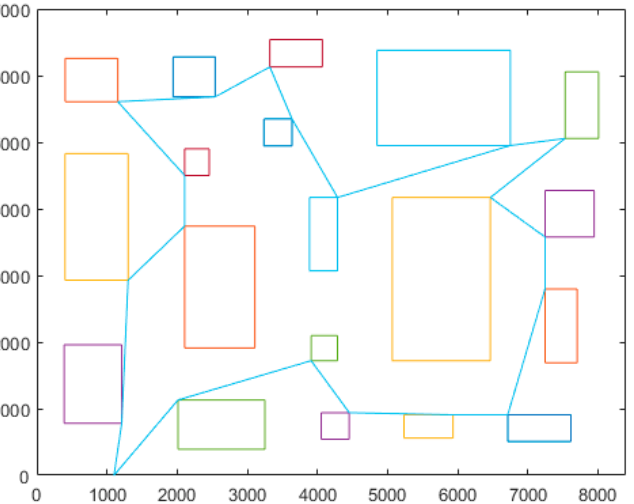
Figure 7. Path planning results.